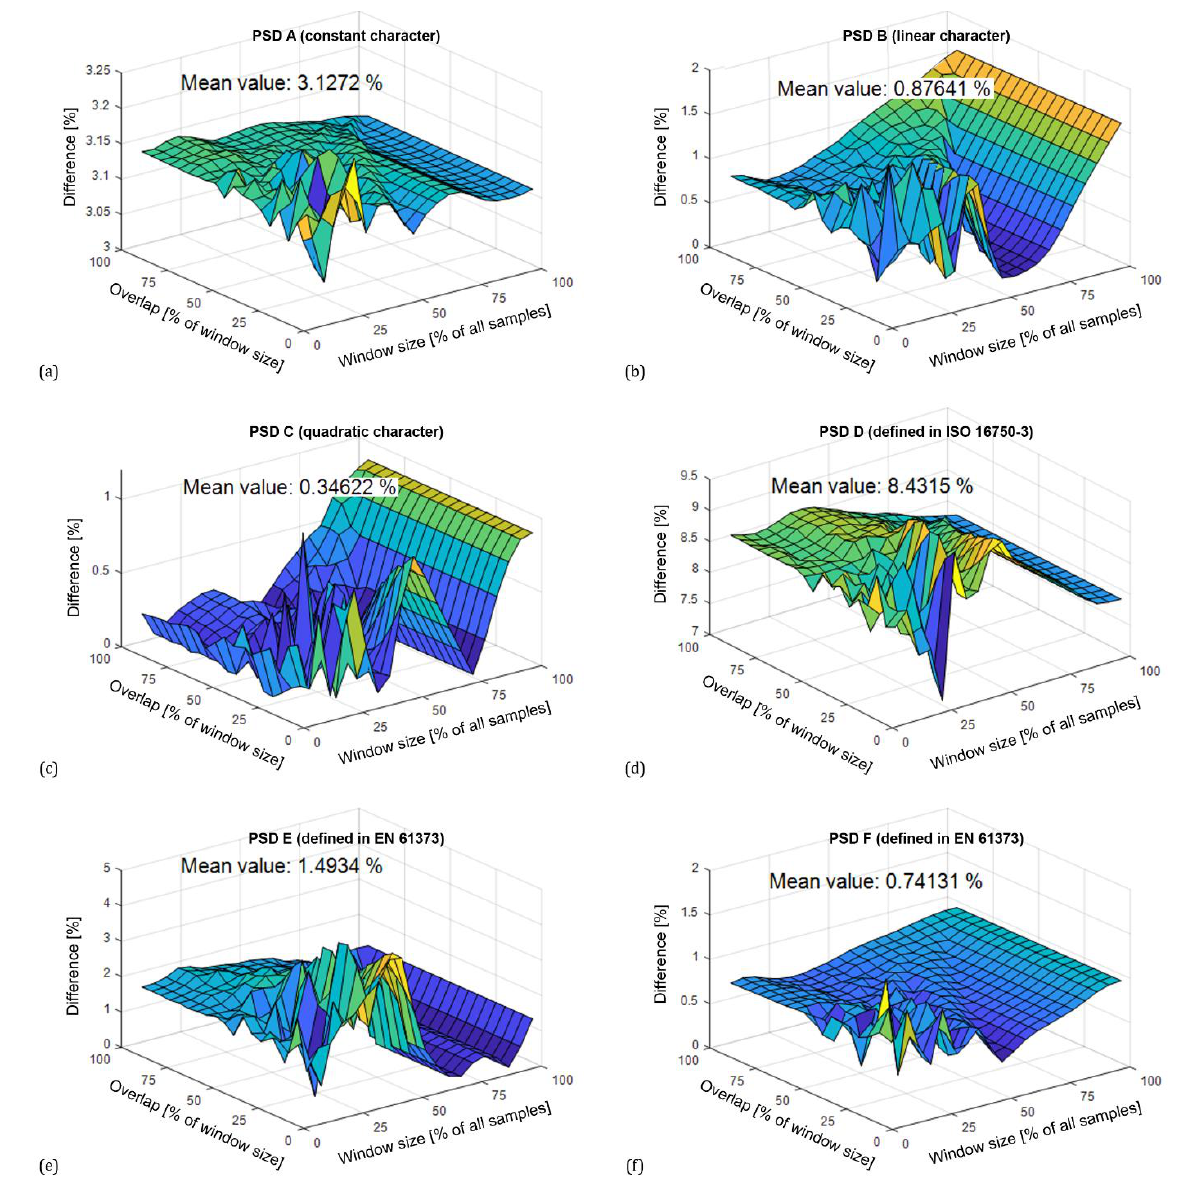
Figure 11. Percentage difference between Dirlik and Tovo–Bennasciutti models (Hanning window). Comparisons prepared according to PSD using constants (a), constants with linear connection (b), constants with quadratic connection (c), standardized PSD functions according to ISO 16750-3 (d) and EN 61373 (e)-(f).